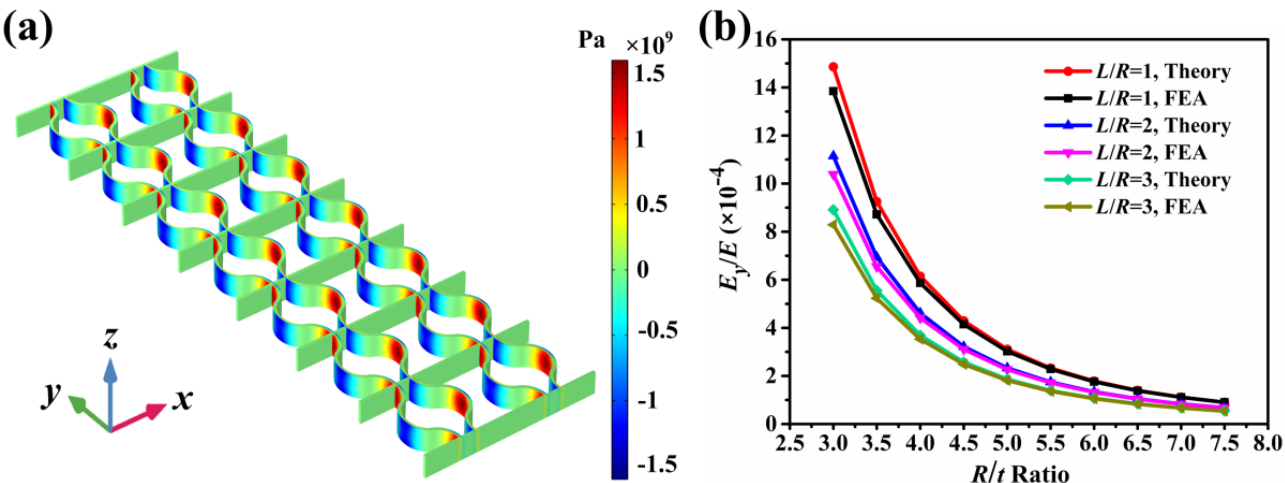
Figure 3. ( a ) Stress distribution of the active SMA honeycomb array at 35% tensile strain; ( b ) the variation of non–dimensional in–plane equivalent elastic modulus versus the R / t ratio at different L / R ratios.